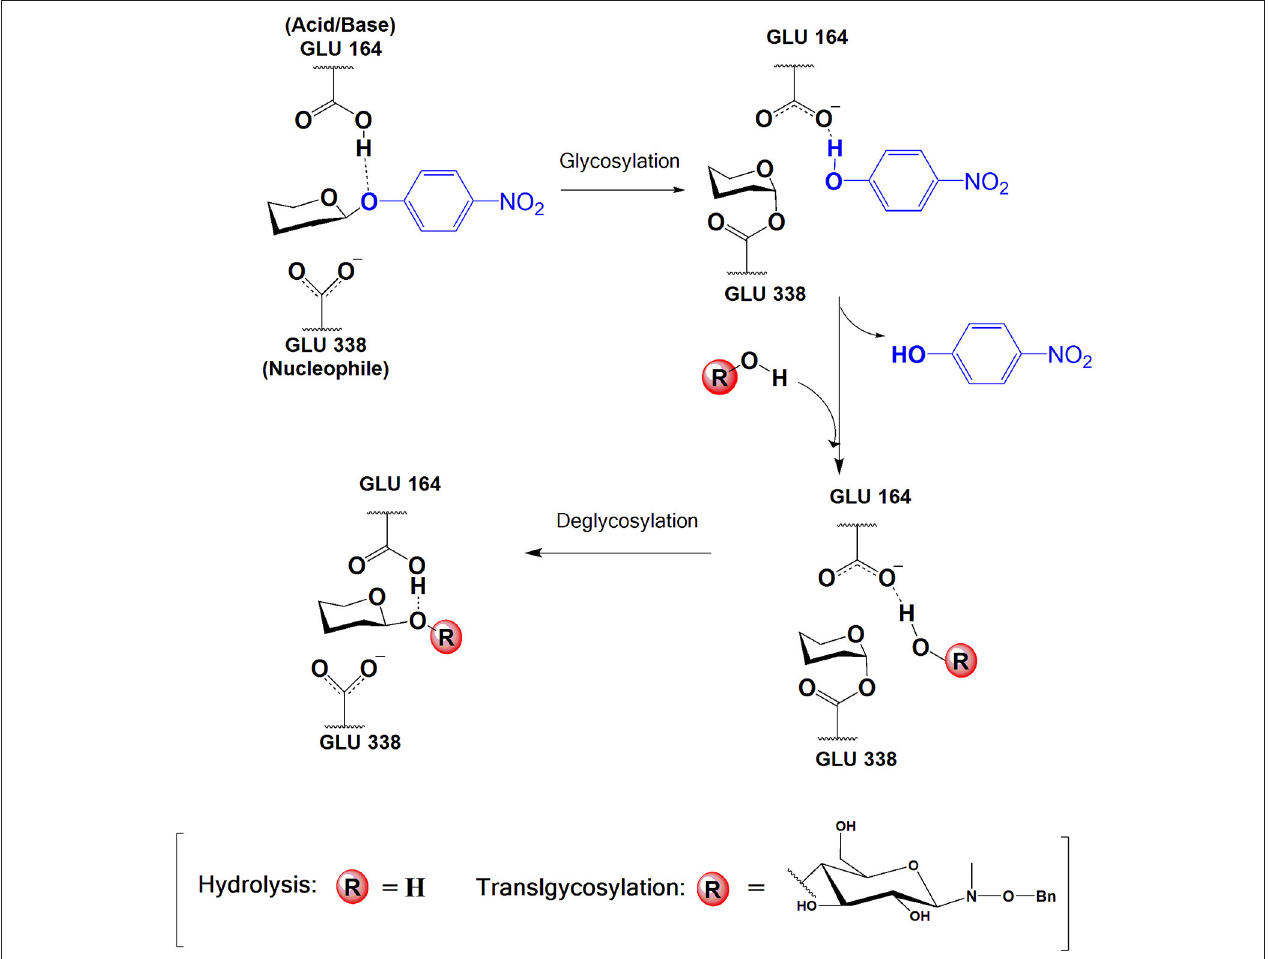
FIGURE 1 | Catalytic mechanism of the glycosylation and deglycosylation (hydrolysis or transglycosylation) steps in retaining β -glycoside hydrolases. In this work, nucleophile and acid/base residues are GLU 338 and GLU 164, respectively, the donor substrate is p NP-Fuc and the acceptor substrate for transglycosylation is